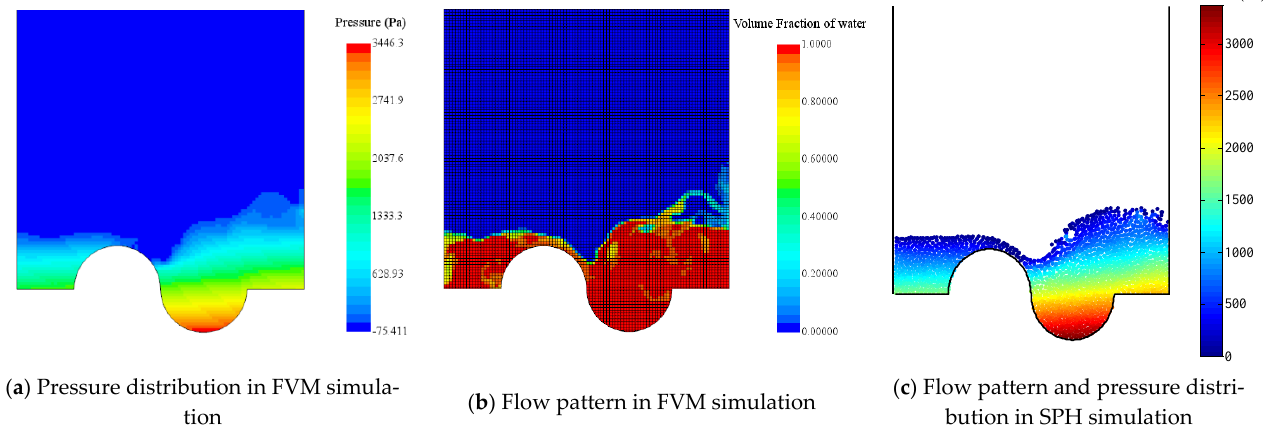
Figure 10. The advantage and robustness of the new SBT algorithm can be validated by the violent sloshing simulation with coarse boundary particles distribution.